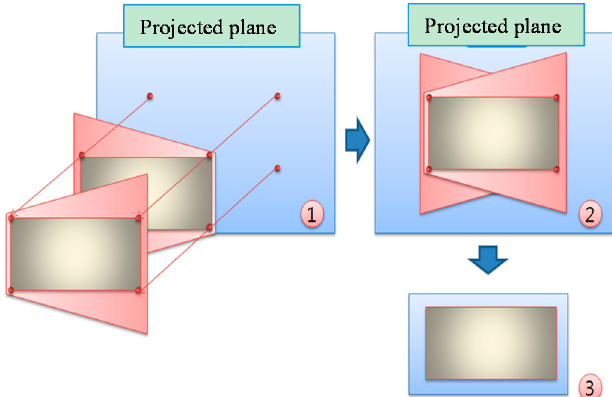
Figure 3. ( a ) Q plane of the original image; ( b ) q plane of the air view image of ( a ).